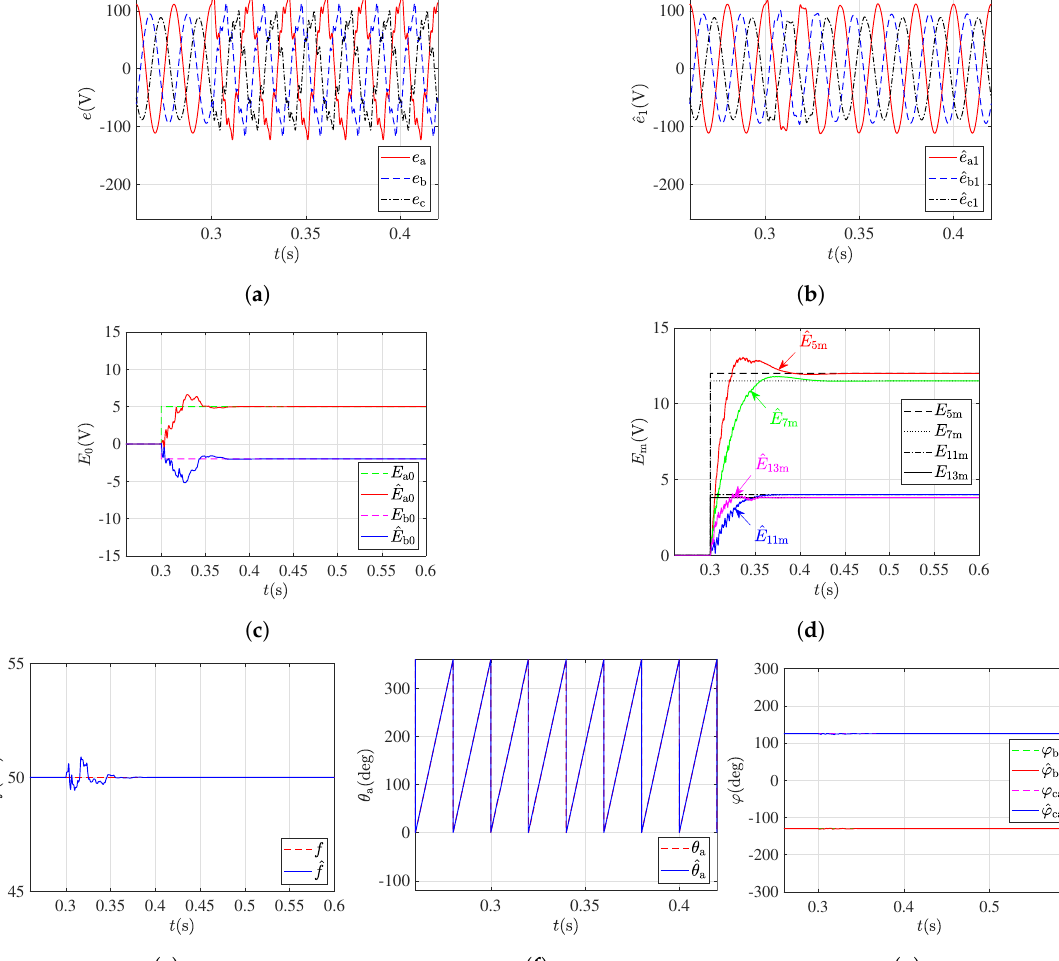
Figure 7. Simulation results when three-phase unbalanced voltages are suddenly injected with DC offsets and higher harmonics. The waveforms of (a) e abc ; (b) ˆ e abc1 . The actual and estimated parameters of (c) E a0 , E b0 ; (d) E 5m , E 7m , E 11m , E 13m ; (e) f ; (f) θ a ; (g) ϕ ba , ϕ ca